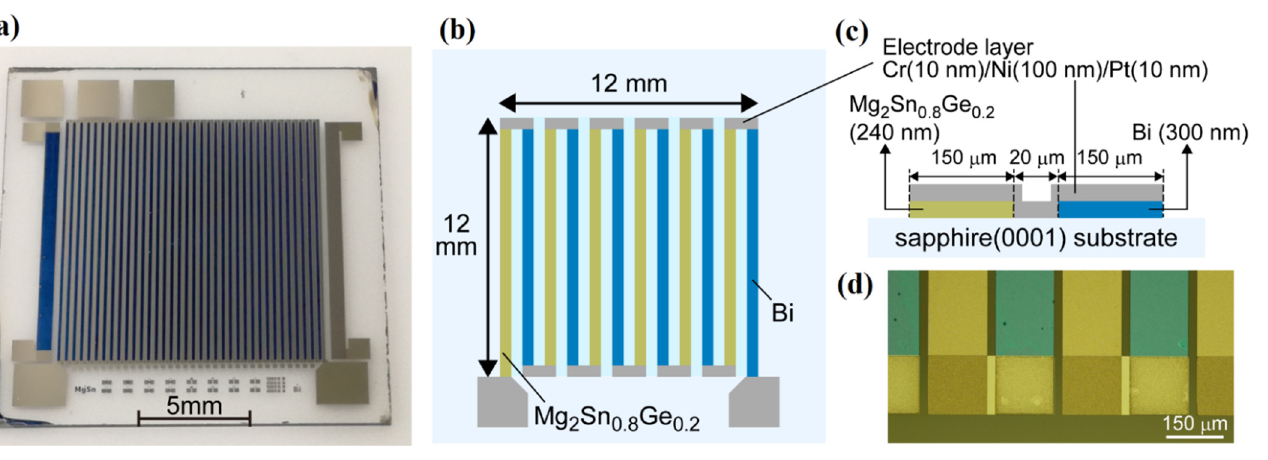
Figure 15. ( a ) In-plane π -type thermoelectric device constructed by microfabrication, ( b ) schematic, ( c ) cross-section view at a π junction (p-type Mg 2 Sn 0.8 Sn 0.2 /metal electrode/n-type Bi), ( d ) microscopy image around the π junctions